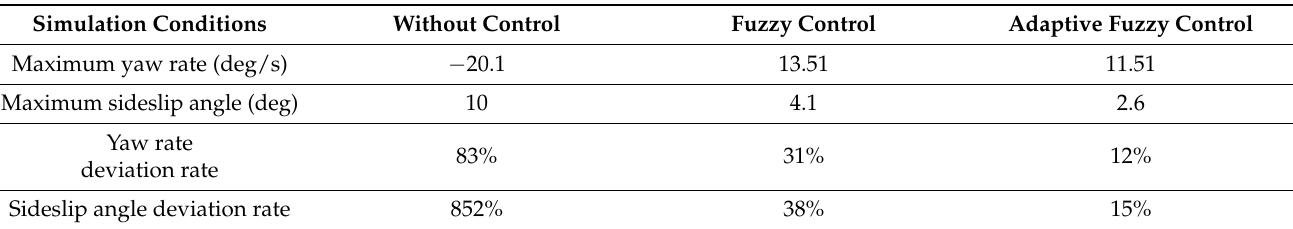
Figure 20. ( a ) Speed, ( b ) torque, ( c ) yaw rate, ( d ) sideslip angle, and ( e ) lateral acceleration. Table 5. Comparison of simulation results from the slalom test at medium speed. Table 5. Comparison of simulation results from the slalom test at medium